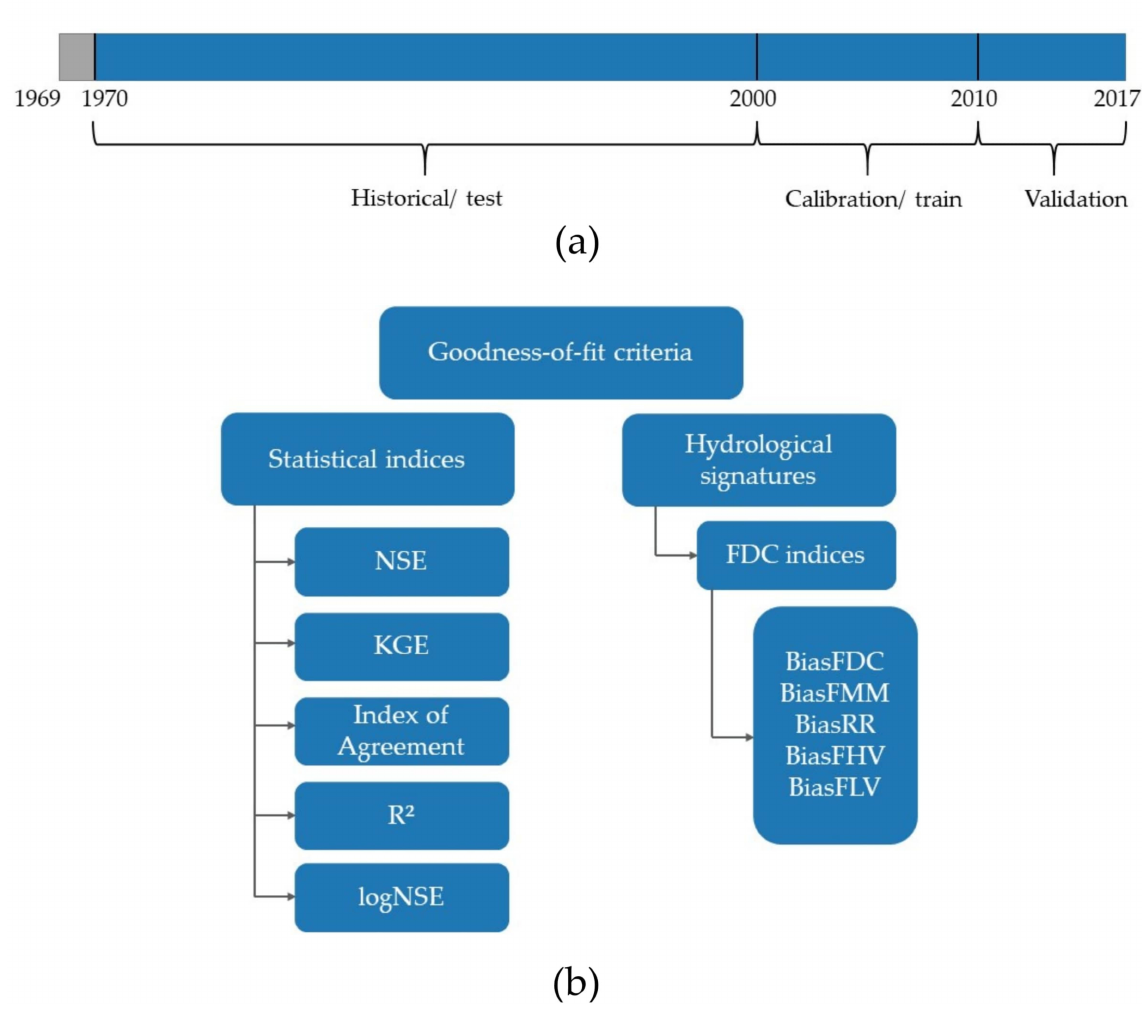
Figure 3. ( a ) Time ranges applied for the different model types during the modeling process. ( b ) Overview of all goodness-of-fit criteria used to evaluate the model